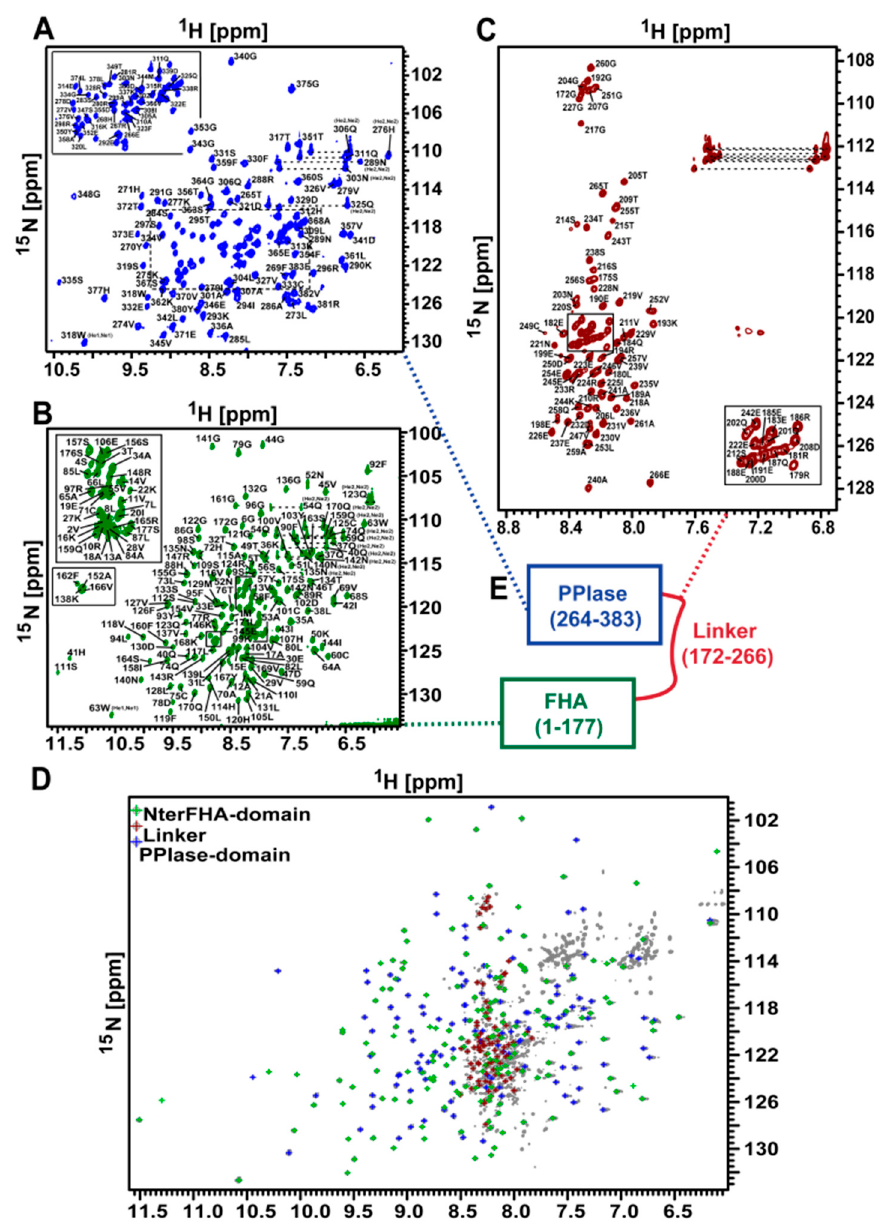
Figure 9. The domains of Tb Par42 do not interact with each other ( A ) Fully assigned 1 H- 15 N-HSQC spectrum of the PPIase domain 264-383 . ( B ) Fully assigned 1 H- 15 N-HSQC spectrum of the N-terminal extended FHA domain 1–177 . ( C ) 96.6% assigned 1 H- 15 N-HSQC spectrum of the linker 172–266 region. ( D ) Overlay of the Tb Par42 full-length TROSY spectrum with the HSQC spectra of the separately analyzed domains and the linker of Tb Par42. ( E ) Scheme of domain organization.